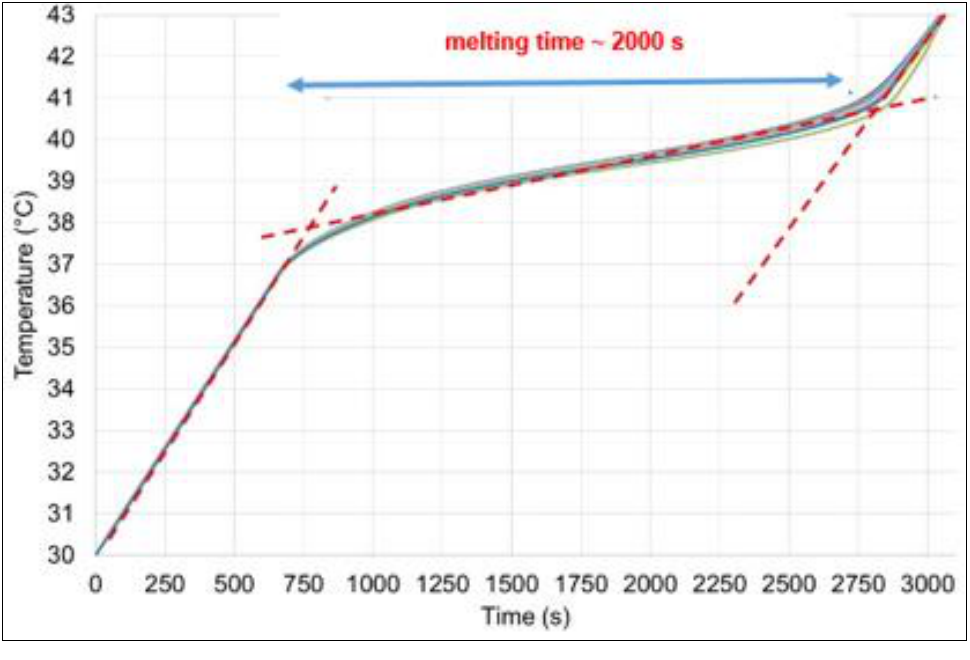
Figure 13. Average external temperature of the cells estimated by CFD calculations with P = 0.55 W/cell.